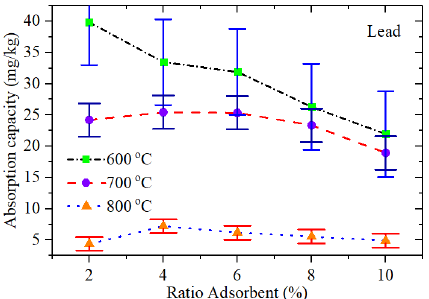
Figure 8. Total absorption capacity Pb with ratio and different